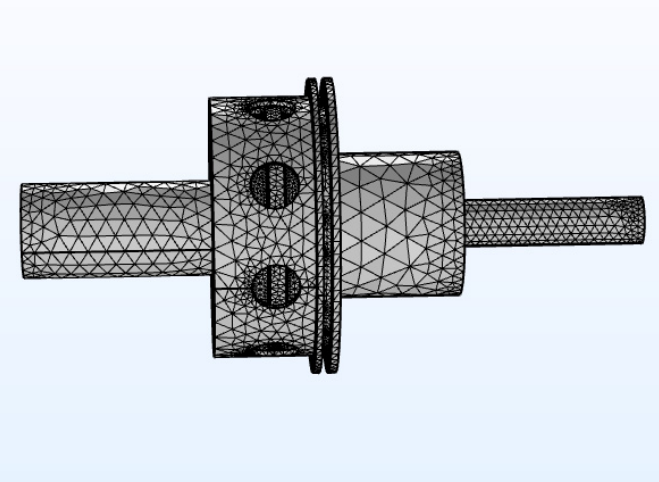
Figure 7. The meshing of a friction clutch in the temperature model. Table 2. The mechanical and thermal properties of friction plate and steel.